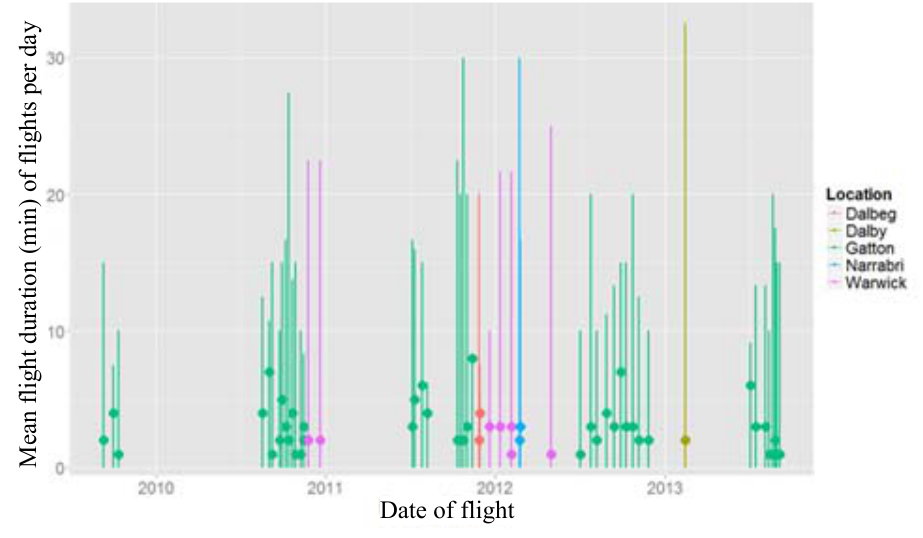
Figure 3 . The average duration of flights (columns) and number of flights per day (symbols) between September, 2009, and September, 2013, at five locations for crops of wheat (Gatton 27.55° S, 152.34° E), sorghum (Dalby 27.36° S 151.24° E, Warwick 28.22° S, 152.10° E), sugarcane (Dalbeg 20.2° S, 147.3° E) or cotton (Narrabri 30.20° S, 149.61°